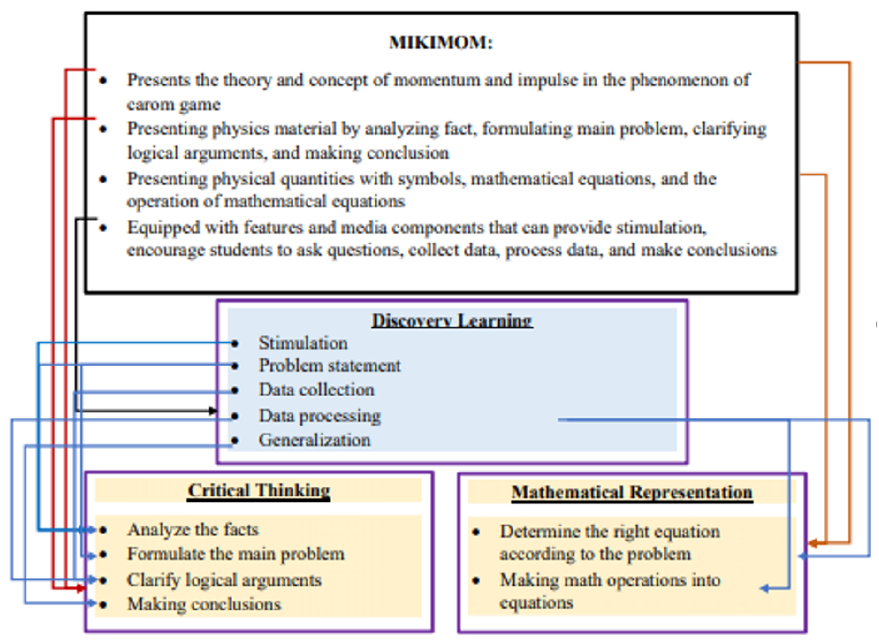
Figure 1. Conceptualization of MIKIMOM as a learning media that integrated with discovery learning to improve critical thinking and mathematical representation abilities